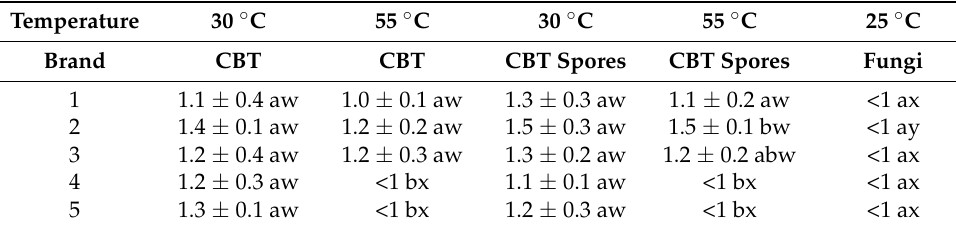
Table 6. Microbial population of cacao powder of 5 different brands sold in the Italian market. Temperature